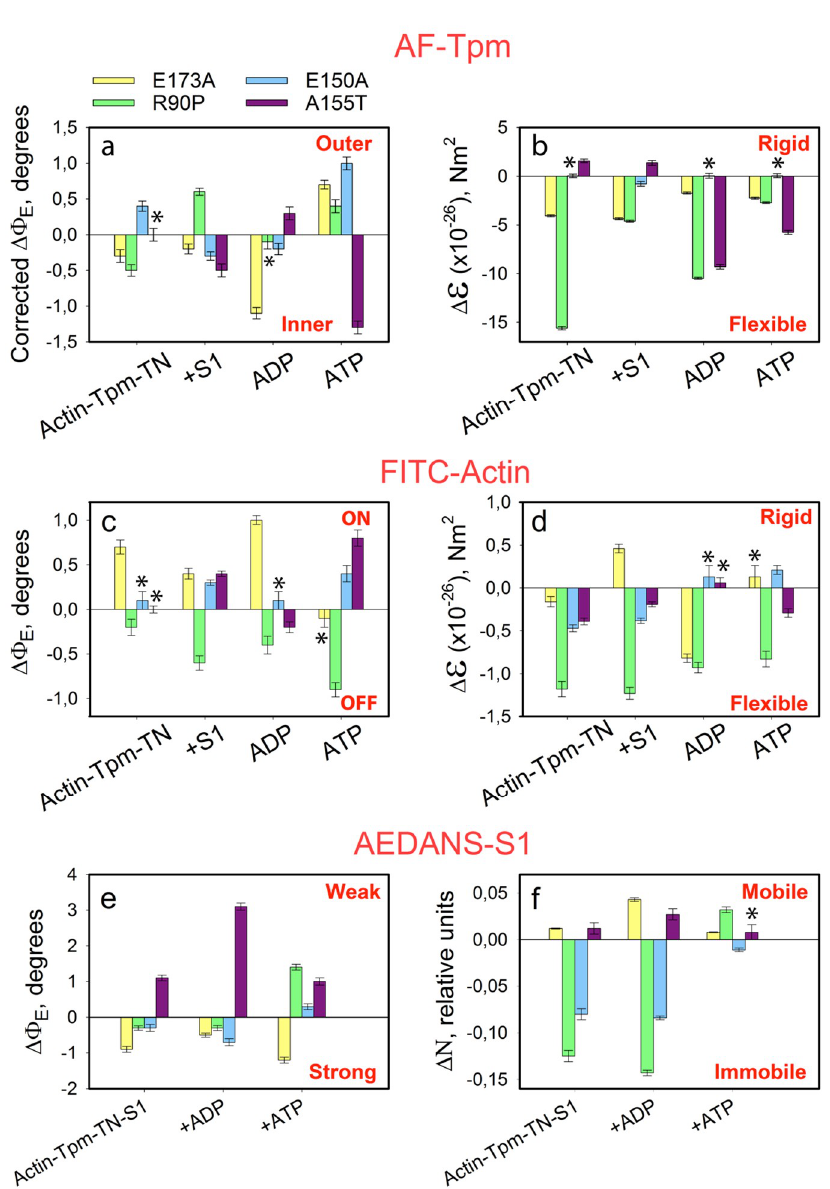
Figure 8. The effect of the E173A, R90P, E150A, and A155T mutations in γ-Tpm on the changes in the polarized fluorescence parameters observed at transition between the mimicked stages of the ATPase cycle at high Ca 2+ . The changes in the values for the angle Ф Е ( a , c , e ) from AF-Tpm, FITC-actin, and AEDANS-S1, respectively, the changes in the values for the bending stiffness ε ( b , d ) determined on the basis of analysis of the polarized fluorescence from 5-IAF and FITC-phalloidin, respectively, and the changes in the values for N ( f ) from 1,5-IAEDANS are shown. The data represent differences in the values of Ф Е (ΔФ Е ), ε (Δε), and N (ΔN) between WTTpm and each of the mutant Tpms. Yellow, green, blue, and lilac columns show data for the filaments decorated with the E173A, R90P, E150A, and A155T mutant Tpms, respectively. They represent means of 8–10 ghost fibers for each experimental condition (see Section 4). The values of the ΔФ Е , Δε and ΔN for the E173A, R90P, E150A, and A155T mutant Tpms are significantly different from the corresponding values for WTTpm both in the absence and in the presence of nucleotides ( p < 0.05). Error bars indicate ± SEM. The asterisks were used to indicate statistically unreliable differences between the mutant and wild-type Tpms.